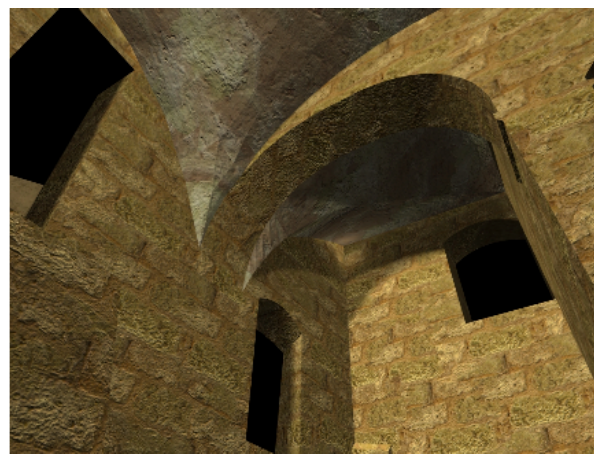
Figure 6. overview of the textured